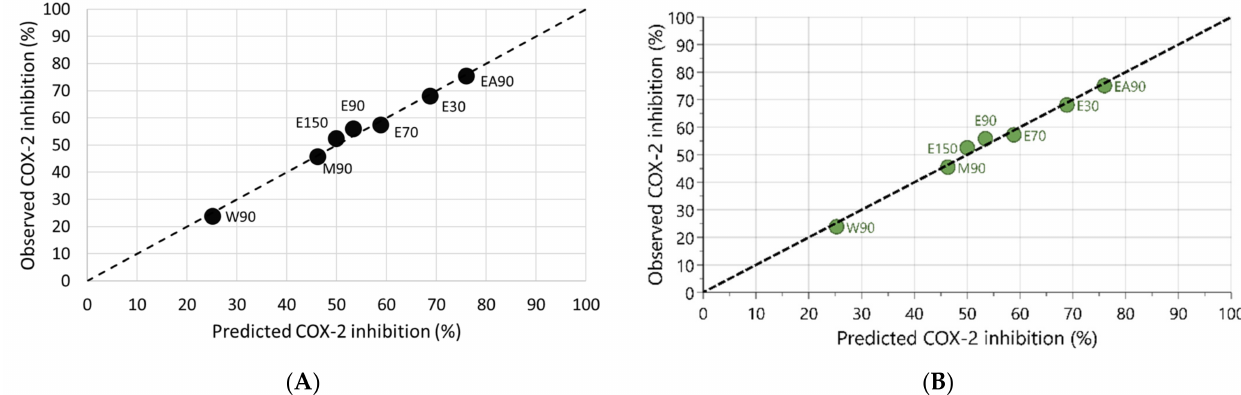
Figure 8. Graphs representing ( A ) model A linearity plot of observed versus predicted COX-2 inhibition of Waltheria indica extracts (RMSE = 1.6%) based on the obtained linear fit equation y = 0.257x + 20.911 generated by the weighted sum of the contributors versus COX-2 inhibitory activity and ( B ) model B linearity plot of observed versus predicted COX-2 inhibition (RMSE = 1.6%) based on the generated linear fit equation y = 0.0693a + 0.1269b + 2.1269c + 2.5925d + 20.9035 by PLS regression. Dashed lines represent the line of identity (y = x). y = predicted COX-2 inhibition (%); x = weighted sum concentration of the contributors; a = triterpenoid saponin concentration; b = steroidal saponin concentration; c = square root concentration of ALA; d = square root concentration of